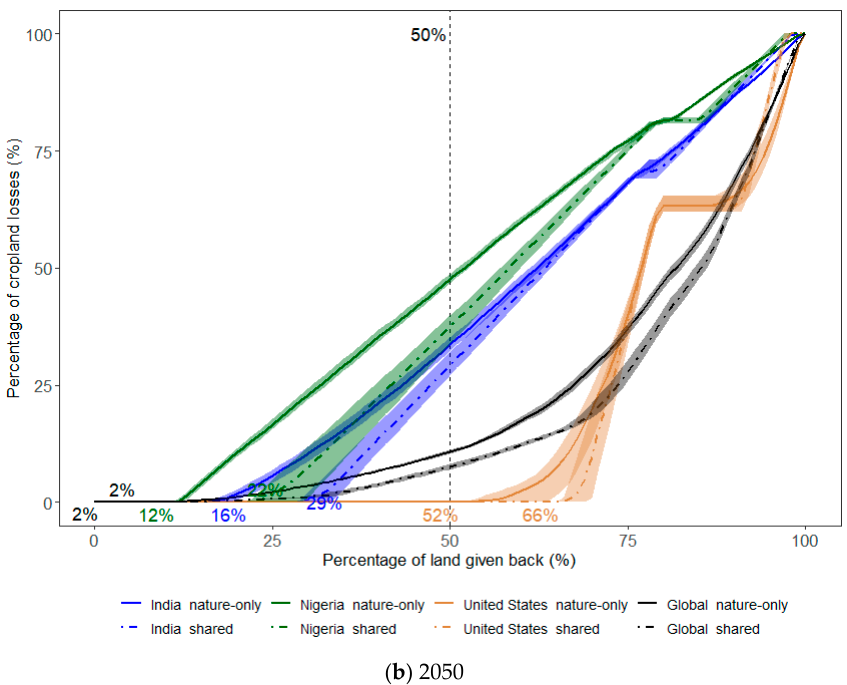
Figure 9. Cropland losses of typical countries and the globe at the national scale. The curve reflects the mean value of all 8 scenarios and the shadows show ranges of all scenarios. The specific percentage of land given bank at which cropland begins to be abandoned is marked. Land given back and cropland losses are both shown in percentages. Table 1. 2030 nature-only: percentage of conserved area to global terrestrial area.